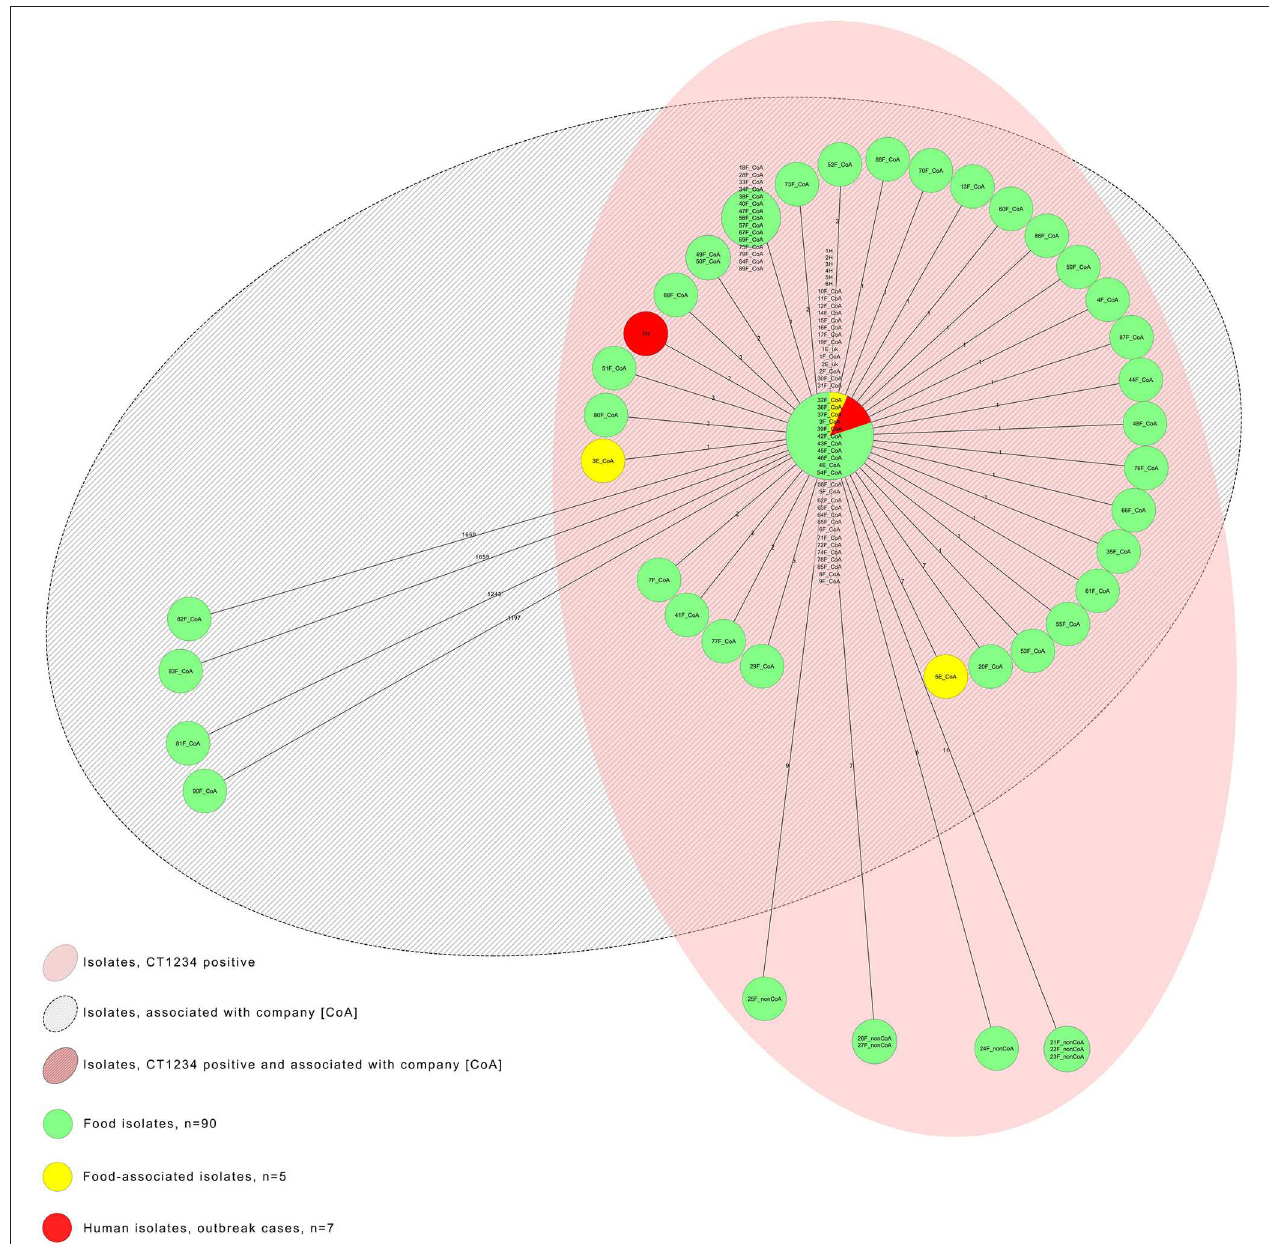
FIGURE 3 | Adapted minimum spanning tree of the seven human outbreak isolates, the food and environmental isolates of L. monocytogenes , including the company A associated and non-associated CT1234-isolates (CoA CT1234-isolates and nonCoA CT1234-isolates; n = 90), and the five company A associated nonCT1234-isolates; N =